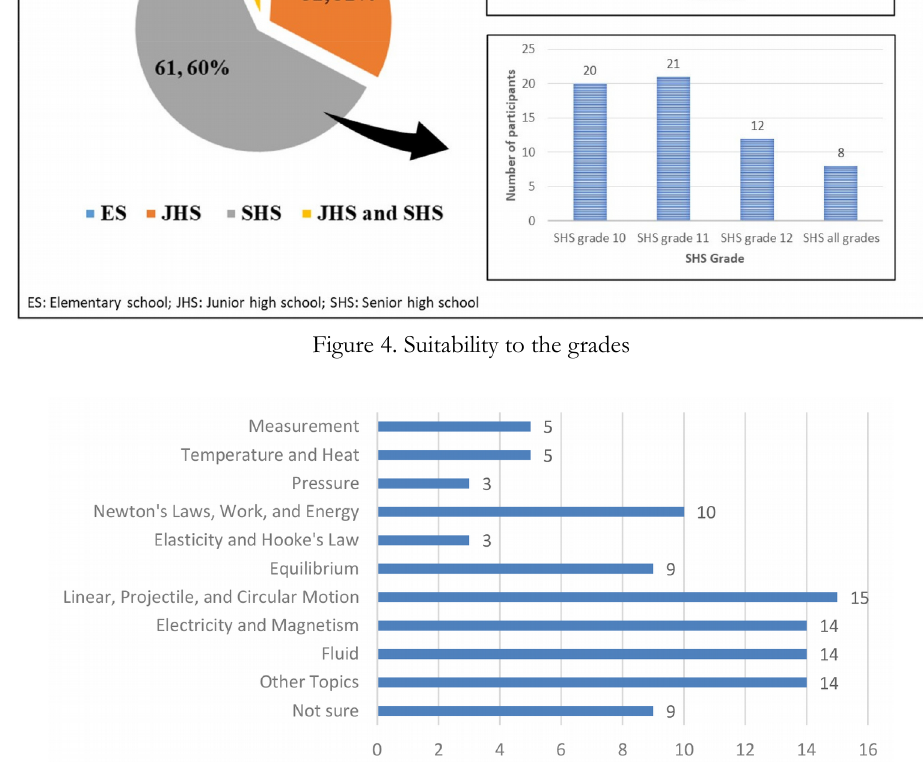
Figure 5. Suitability of STEM to the topics in the